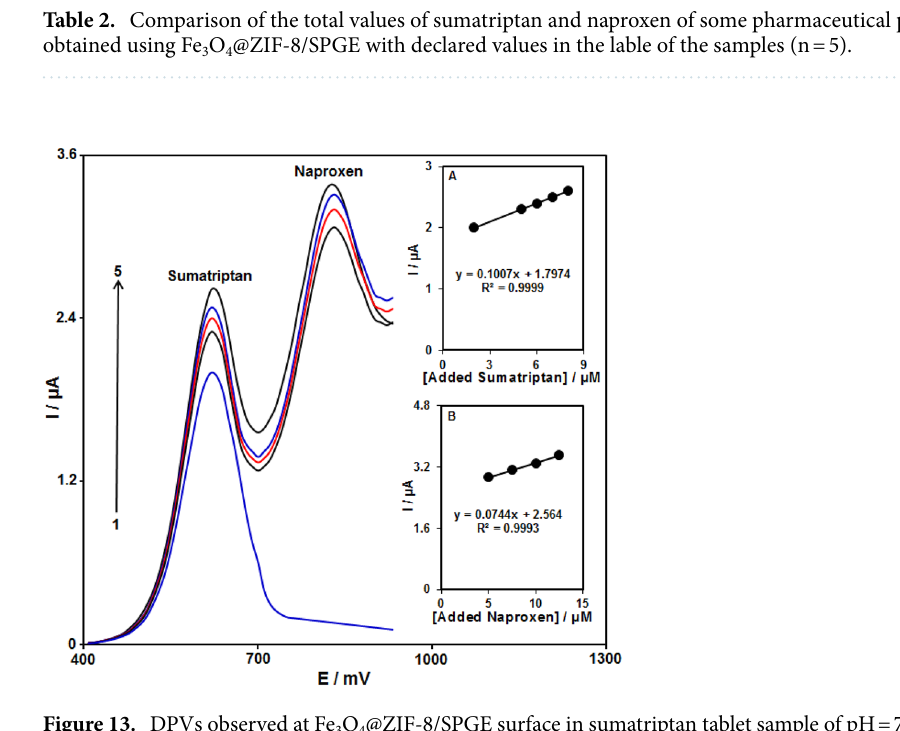
Figure 13. DPVs observed at Fe 3 O 4 @ZIF-8/SPGE surface in sumatriptan tablet sample of pH = 7.0 (0.1 M PBS) with distinct concentrations of sumatriptan as well as naproxen. As seen, the DPV numbers 1–5 has been relative to 2.0 + 0.0, 5.0 + 5.0, 6.0 + 7.5, 7.0 + 10.0 and 8.0 + 12.5 µM sumatriptan and